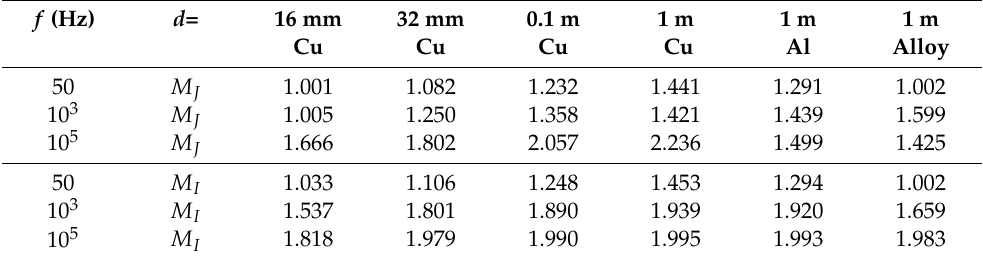
Table 1. Example 3, α = 0: The dependences of M J = J max /ˆ J max and M I = I max /ˆ I on f , d and (cid:36) . f (Hz) d = 16